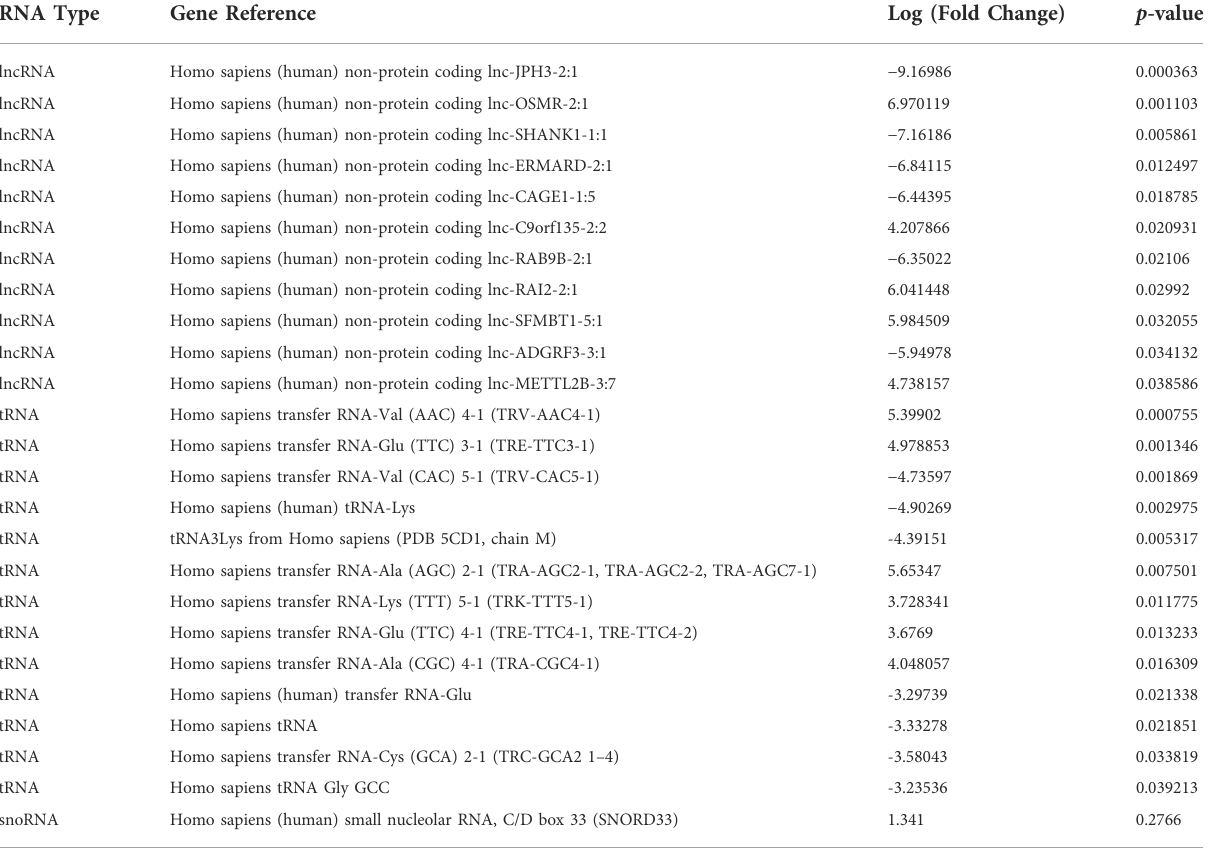
TABLE 2 Differentially expressed small ncRNAs in senescent fi broblast derived EVs compared to non-senescent control EVs. RNA